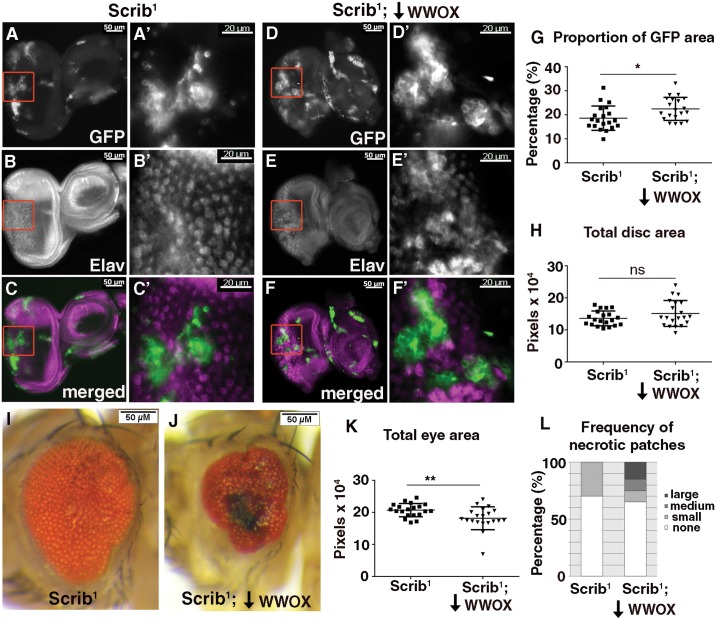
WWOX is required for elimination of Scribbled (Scrib) mutant clones.
(A-A’) Clones of cells mutant for Scrib generated in the eye using the MARCM system are positively labelled with GFP. (B-B’) Elav staining reveals absence of differentiated photoreceptors within a portion of Scrib mutant clones. (C-C’) Merged image showing GFP in green and Elav in magenta. (D-D’) GFP expressing Scrib mutant clones with decreased WWOX expression (Scrib
1; WWOX-IR). (E-E’) Elav staining reveals absence of differentiated photoreceptors within a portion of the Scrib
1;WWOX-IR mutant clones. (F-F’) Merged image showing GFP in green and Elav in magenta. Red boxes indicate the regions that are enlarged in D’-F’. (G) Quantification of the proportion of GFP expressing cells showed a significant increase when WWOX expression was decreased in the Scrib mutant clonal tissue compared to the Scrib mutant clones alone. (H) Quantification of total area of the eye disc containing Scrib clones with and without WWOX knockdown revealed no significant difference. (I) Clones of cells mutant for Scrib generated in the eye using the MARCM system result in a mild adult rough eye phenotype. (J) Decreased WWOX expression in the Scrib mutant clones gave a stronger phenotype with a decreased eye size, significant disruption to ommatidial patterning and the presence of necrotic lesions. (K) Quantification of the overall size of the adult eyes showed a significant decrease when WWOX levels were knocked down in Scrib mutant clones. (L) Quantification of percentage of adult fly eye showing necrotic spots of different sizes: Small (550–3000 pixels), Medium (3000–5500 pixels) or Large (>5500 pixels). Genotypes used in these experiments: Scrib
1 = (ey-FLP1, UAS-mCD8-GFP;;tub-GAL4 FRT82B tub-GAL80/ FRT82B, Scrib
1
), Scrib
1;WWOX-IR = (ey-FLP1, UAS-mCD8-GFP; UAS-WWOX-IR#2/+;tub-GAL4 FRT82B tub-GAL80/ FRT82B, Scrib
1
). Significance indicated by * = p<0.05 and ** = p<0.005, ns = not significant.